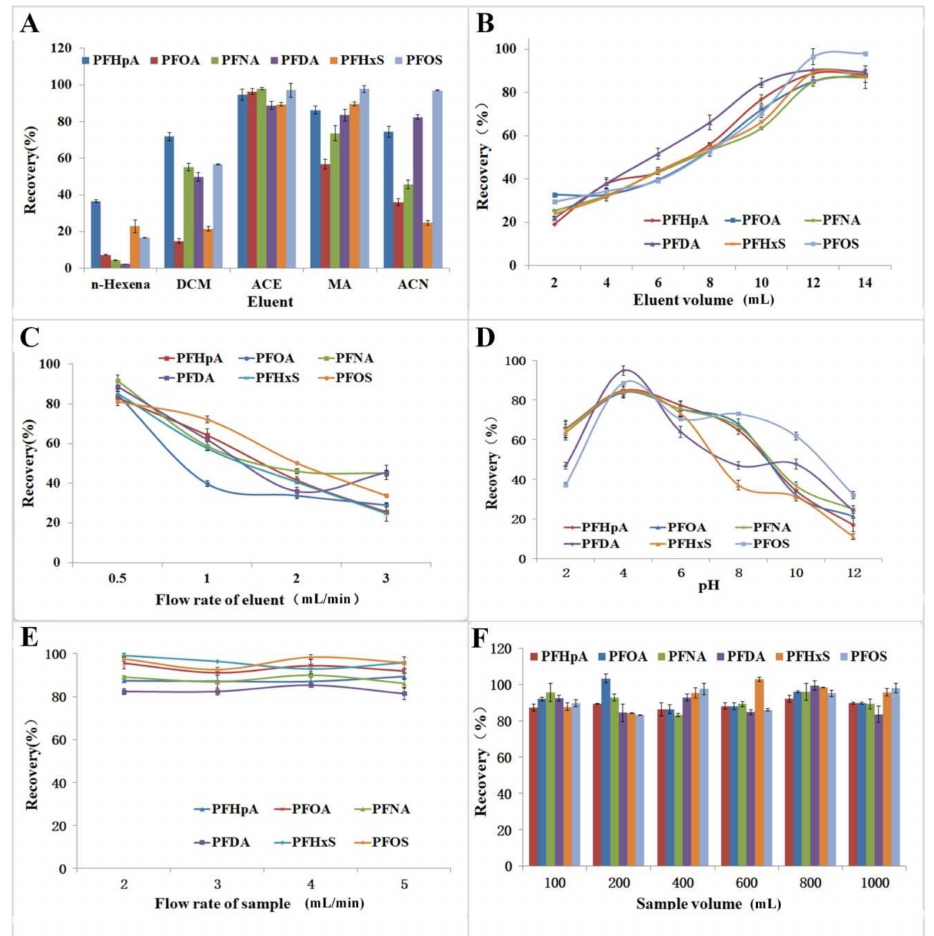
Figure 2. Effects of the: eluent ( A ); eluent volume ( B ); flow rate of eluent ( C ); pH ( D ); flow rate of sample ( E ); and sample volume ( F ) on the recoveries of the six PFAAs. The PFAA concentration in the water samples was 100